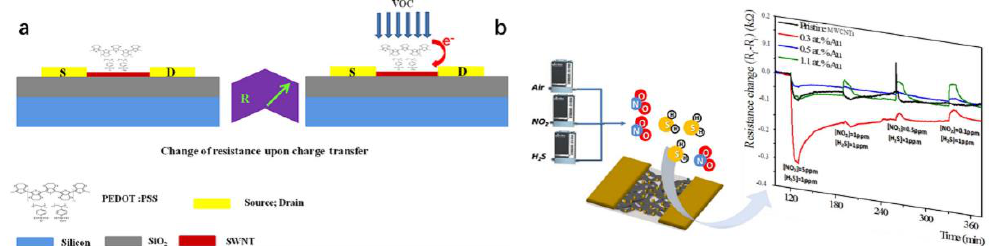
Figure 10. ( a ) schematic diagram of the VOC detection by a single-walled carbon nanotube gas sensor coated with polymer. Reproduced from Sushmee et al. [172] by permission of Elsevier Science Ltd.; ( b ) Different degrees of gold nanoparticles modified the multi-walled carbon nanotube gas sensor detection gas schematic diagram. Reproduced from Palmisano et al. [76] by permission of Elsevier Science Ltd.